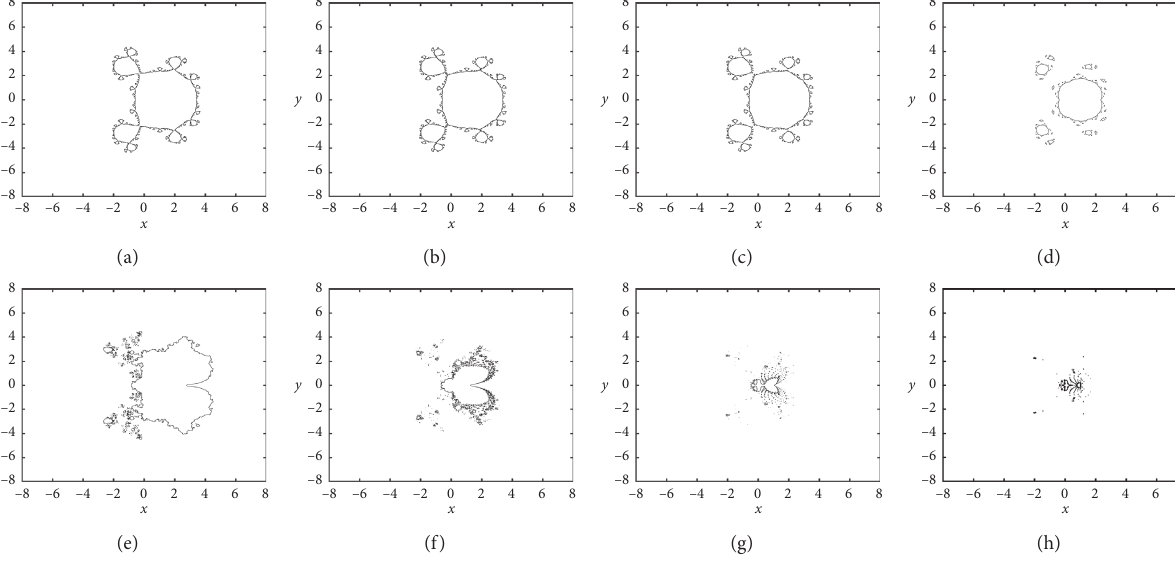
Figure 3: Changing of Julia sets of the discrete fractional system (15) with different values of control parameter k when μ � 6 and p � 2. (a) k � 0 . 2, (b) k � 0 . 6, (c) k � 0 . 65, (d) k � 0 . 9, (e) k � 0 . 1, (f) k � 0 . 3, (g) k � 0 . 5, and (h) k � 0 .